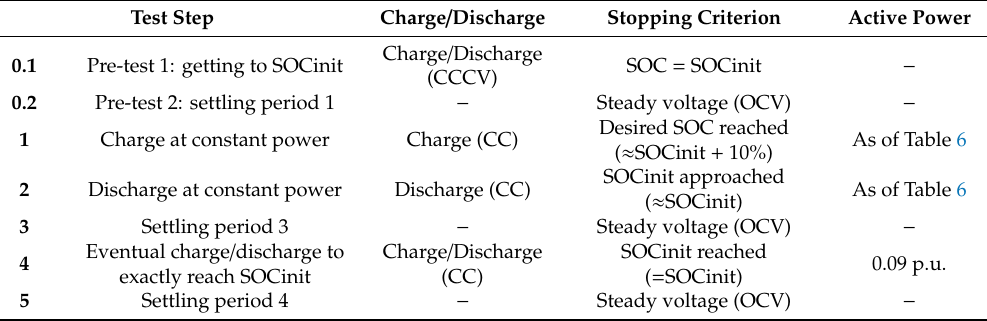
Table 5. Test steps for Set 2.